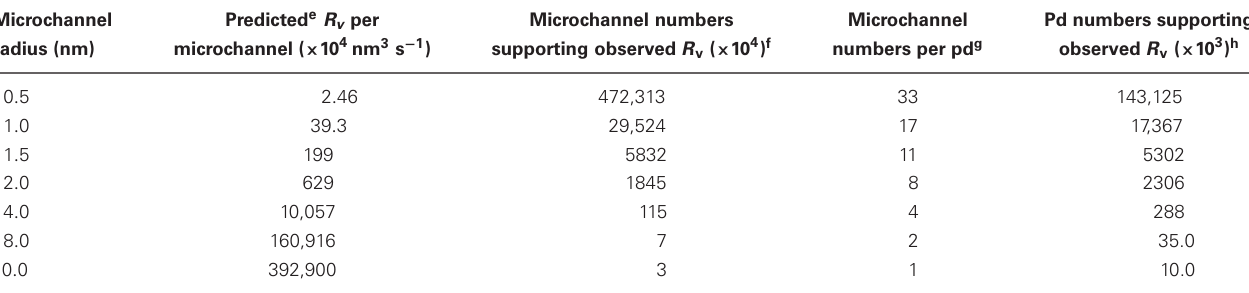
Table 3 | Impact of differing plasmodesmal (pd) microchannel radii a , predicted by the Hagen-Poiseuille Law ( see Equation 1), on plasmodesmal numbers required to support the observed volume flow rate ( R v ) b of phloem sap, of specified viscosity c , symplasmically unloaded from SE/CC complexes to vascular parenchyma cells of developing wheat grains at a transcellular hydrostatic pressure differential of 1.0MPa across the interconnecting plasmodesmata of known length d